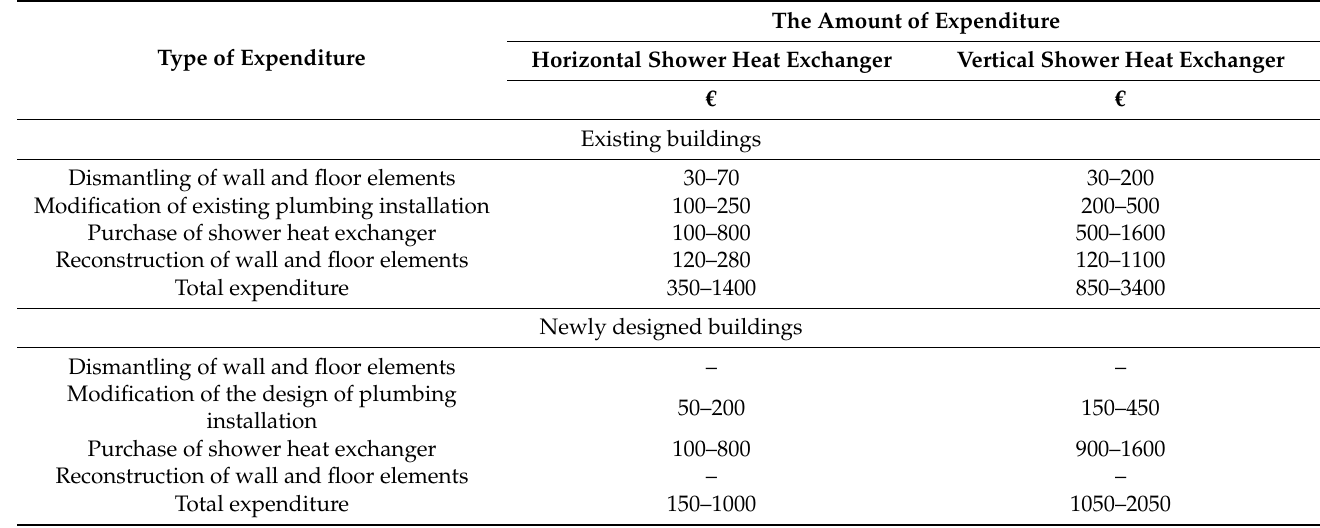
Table 1. The average expenditures to be incurred for the implementation of shower heat exchangers in Polish conditions.